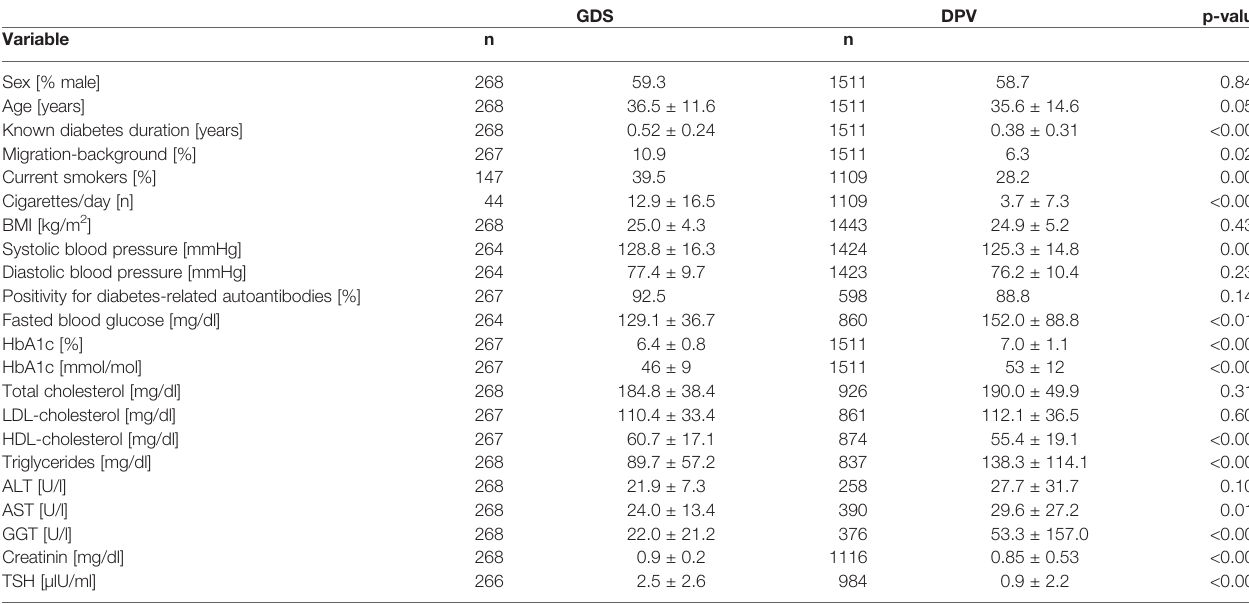
n columns refer to the number of examined patients for each parameter. Data are shown as absolute numbers, percentages, mean ± standard deviation, as applicable. ALT, alanine aminotransferase; AST, aspartate aminotransferase; BMI, body mass index; DPV, Prospective Diabetes Registry; GDS, German Diabetes Study; GGT, gamma-glutamyl transferase; HbA1c, glycated hemoglobin A1c; HDL, high-density lipoprotein; LDL, low-density lipoprotein; TSH, thyroid stimulating hormone.